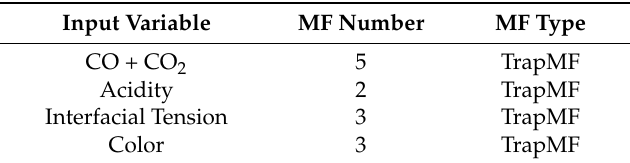
Table 11. Membership function (MF) number and type of created ANFIS